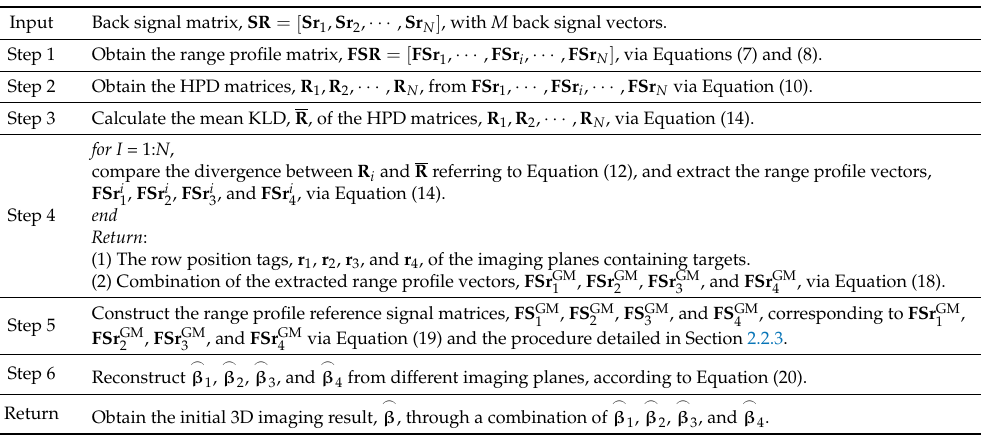
Table 1. Imaging procedure of geometric measure-based terahertz coded-aperture imaging